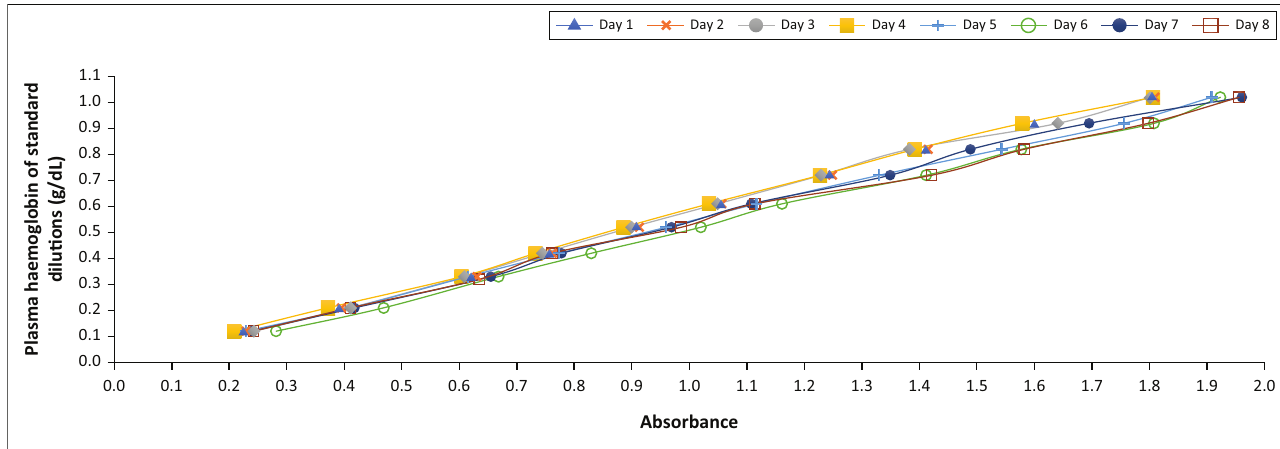
FIGURE 3: Plasma haemoglobin values of the standard concentration series versus the absorbance values obtained on eight consecutive days at the Quality Control Department of the National Blood Center, Sri Lanka, September 2020 – May 2021.